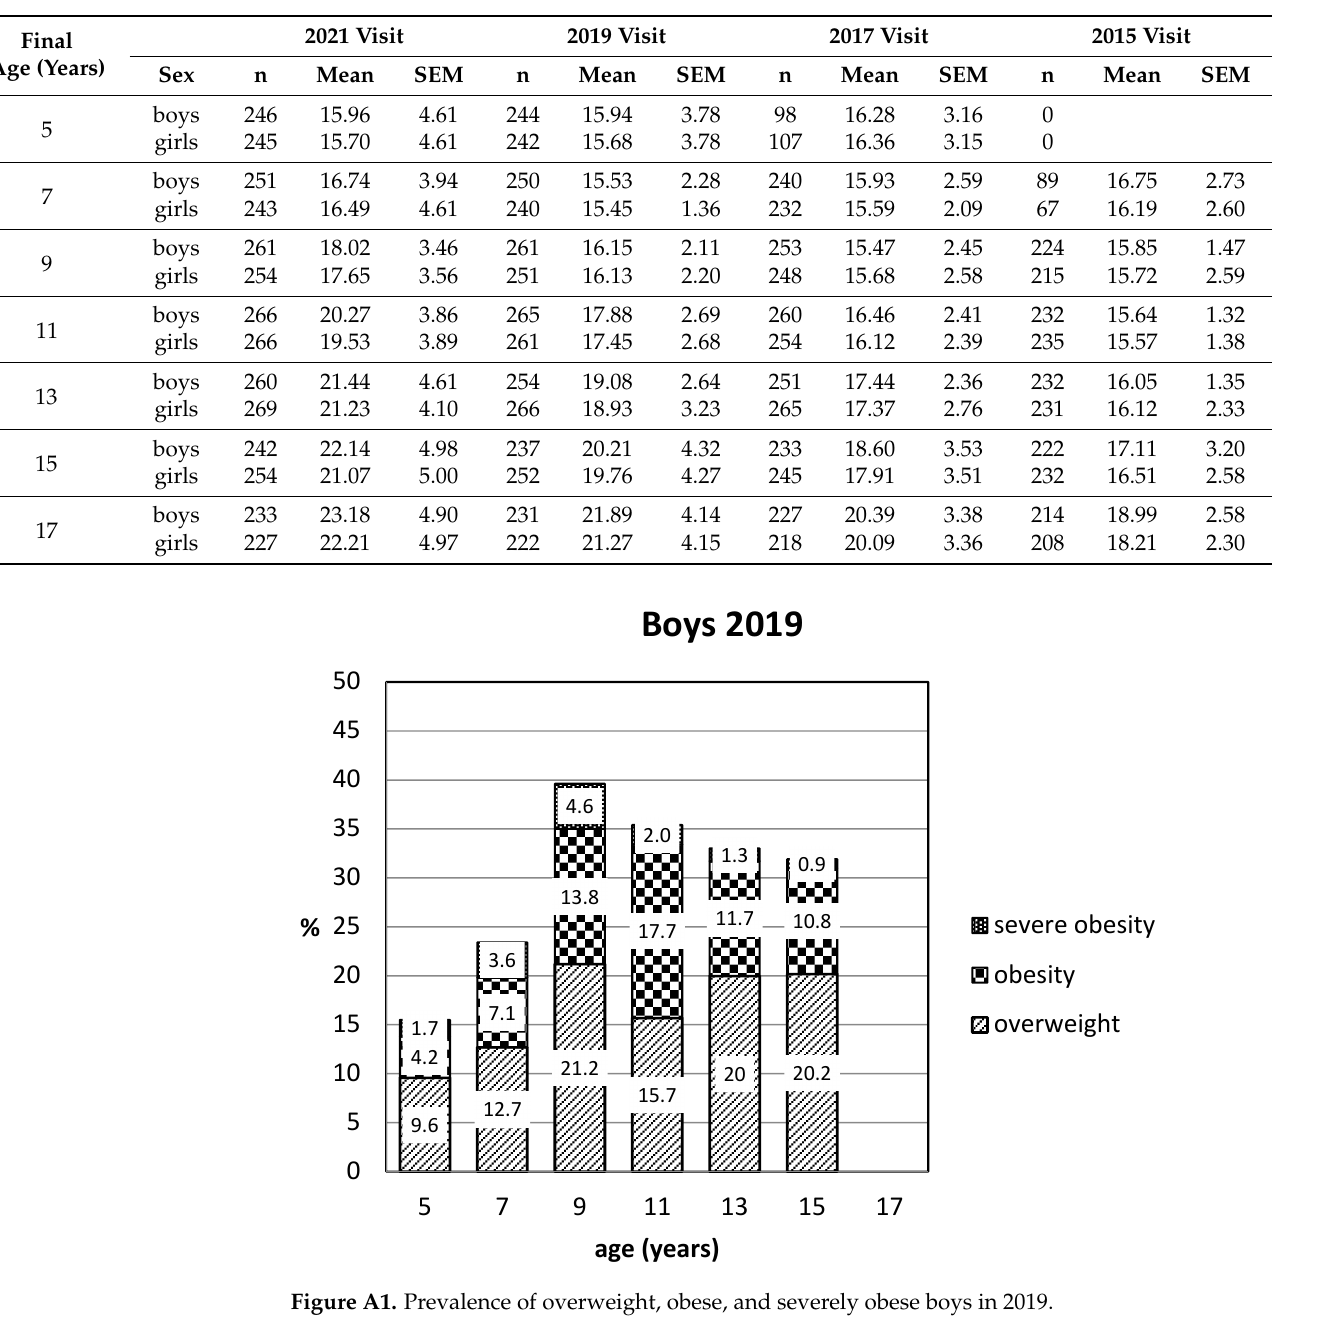
Figure A2. Prevalence of overweight, obese, and severely obese girls in 2019. Table A2. Comparison of data of 7-year-olds from our study with results of WHO project COSI [30].